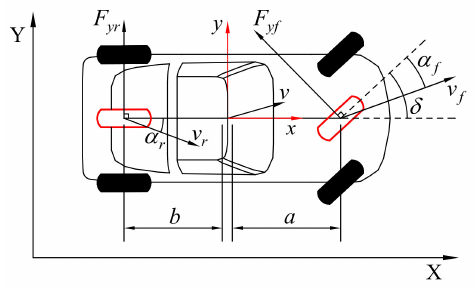
Figure 1. The dynamics model of the